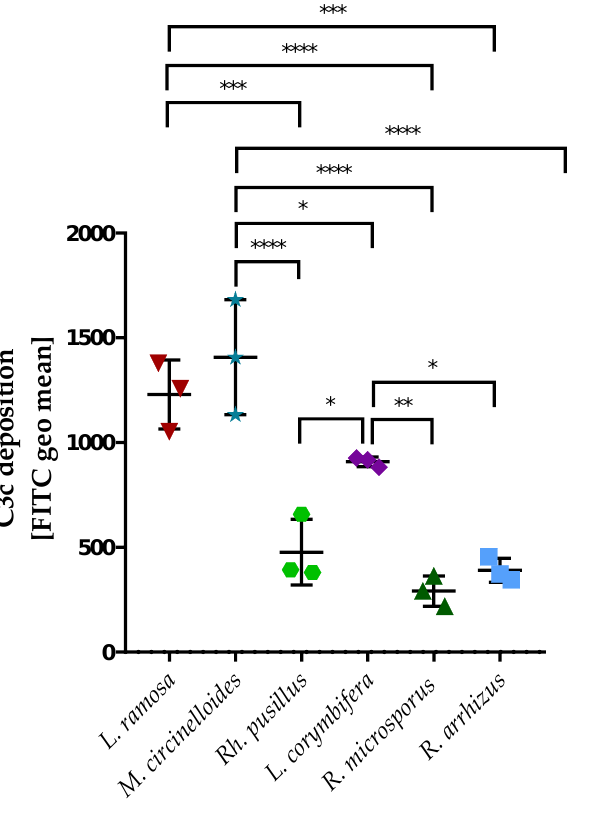
Figure 3. C3c deposition on strains used for the murine model of disseminated mucormycosis. Spores of R. arrhizus , R. microsporus , L. ramosa , L. corymbifera , Rh. pusillus , or M. circinelloides were opsonized with 60% mouse serum for 30 min at 37 °C. A specific anti-C3c antibody was used, and the deposition was measured using fluorescence-activated cell sampler (FACS) Verse with BD software. The deposition of C3c is shown as fluorescein isothiocyanate (FITC) geometric mean (geo mean). The results shown were gained by three independently performed experiments (mean ± SD). Asterisks (*) indicate the level of significance for an adjusted p -value, comparing pairs of groups using a Tukey post hoc test after the one-way ANOVA reported significance.